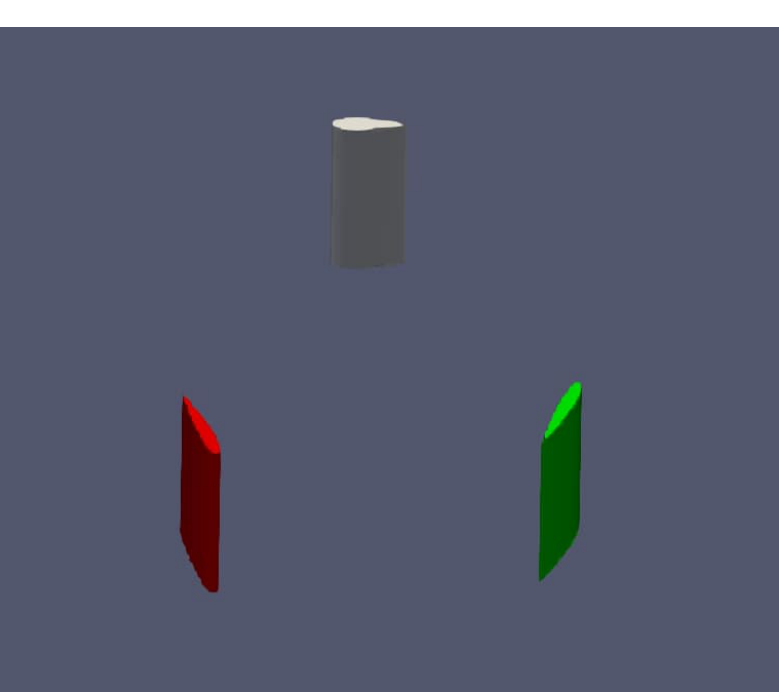
Figure 11. Three-dimensional geometry of the blades of the vertical axis tidal turbine without hub for a sideways view.